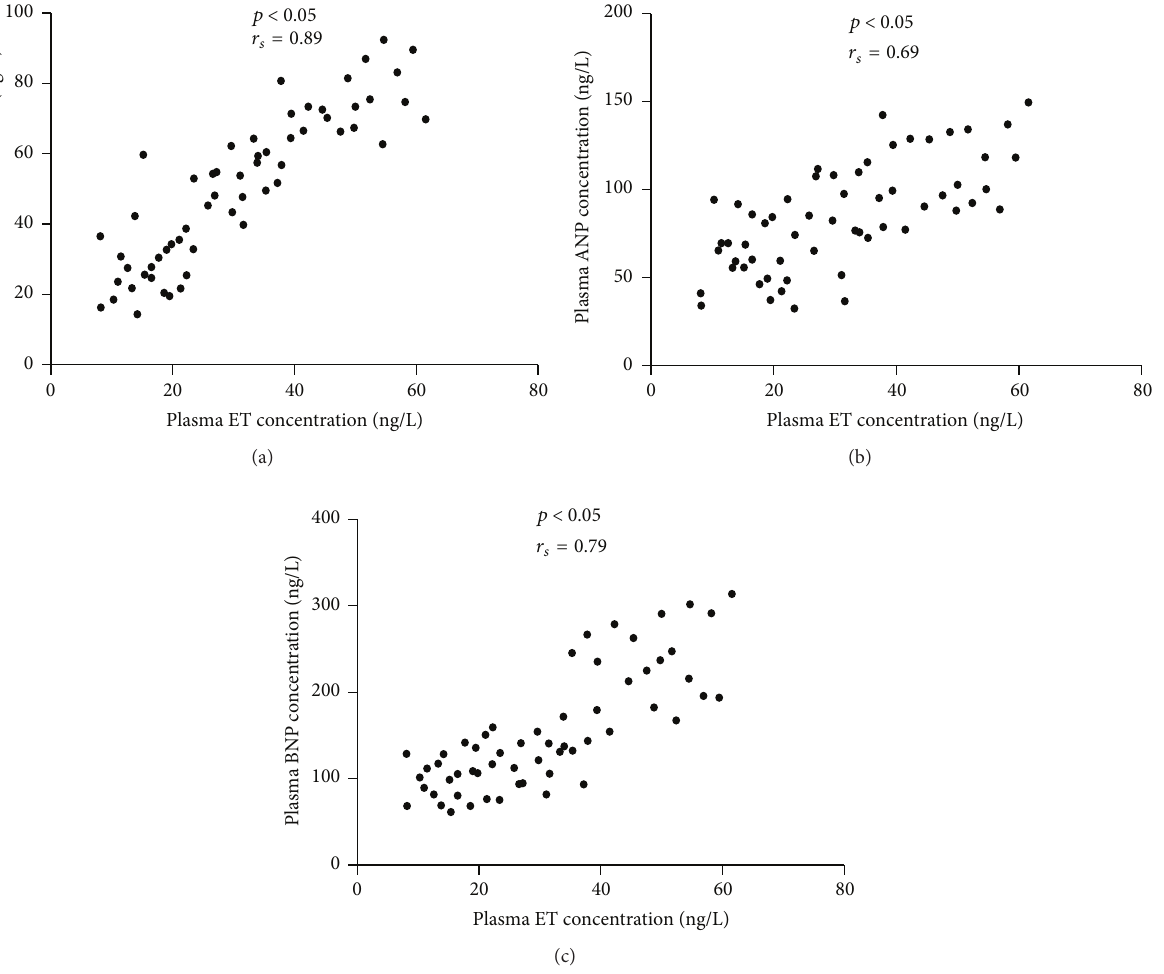
Figure 2: Relationship of plasma ET concentration to values of ADM (a), ANP (b), and BNP (c) in all uroseptic patients.